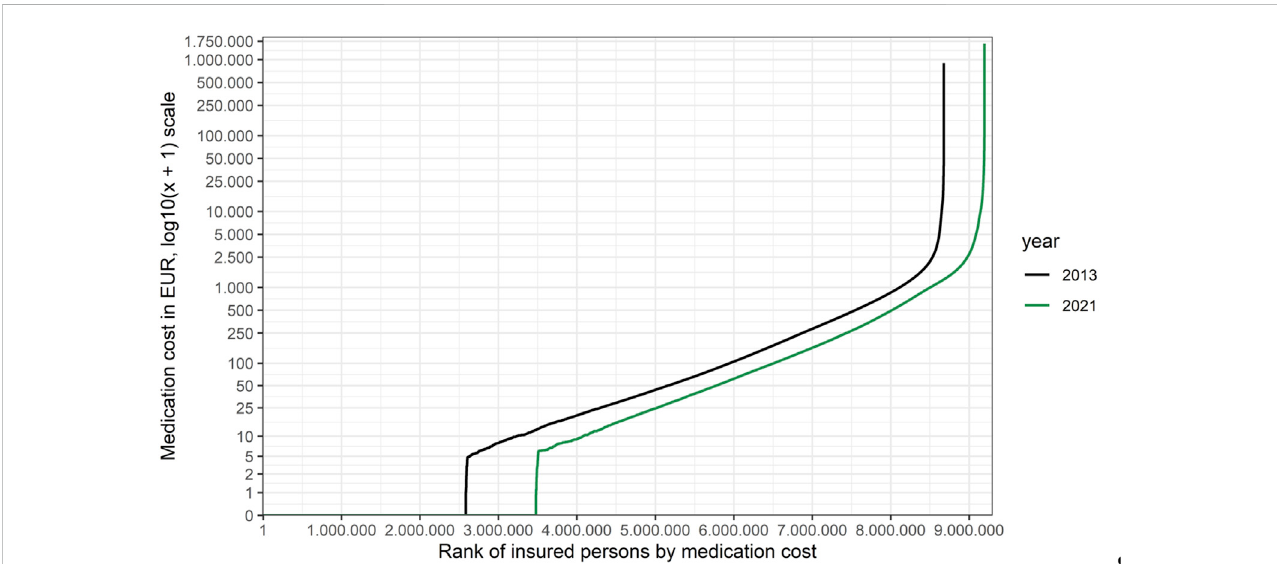
FIGURE 1 Medication costs for individual insured persons in the Austrian public statutory health insurance in 2021 versus 2013. The costs of drug treatments reimbursedfor allindividual,insuredpatientsincurredbytheAustrianpublic statutory health insurancewereretrievedfrom theadministrativedatabaseofthe Austrian Federation of Social Insurances. In total, 99.9% of the Austrian population is covered by the Austrian public statutory health insurance and hence included in the database (Citation: Austrian Federation of Social Insurances (2021) Jahresbericht der Österreichischen Sozialversicherung. URL https:// www.sozialversicherung.at/cdscontent/load?contentid=10008.747502&version=1621948595). The administrative database used holds a complete (pseudonymised) listing of all prescription drugs reimbursed ( € spent, per person, per day). For each year (2021 and 2013) all drug costs per person incurred between 01 January and 31.December were added. Costsare not in fl ation-adjusted. All analyses wereperformed using the statistical software R(version 4.2. 0). (Citation: R Core Team (2022). R: A language and environment for statistical computing. R Foundation for Statistical Computing, Vienna, Austria. URL https://www.R-project.org/). Costs are shown for all insuredpersons (around 9.2 million persons in2021, and around 8.7 million in 2013), ranked fromlowest (left) to highest payments per person (right). Note that the y-axis is logarithmic (log10 (x+1)). The shape of the curves is explained by the fact that